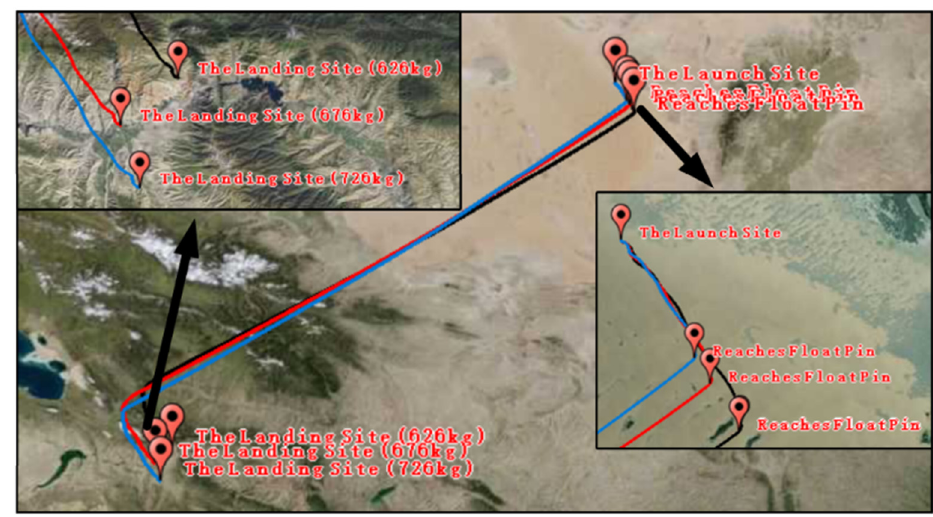
Figure 14. Trajectory predictions for different initial helium weights.